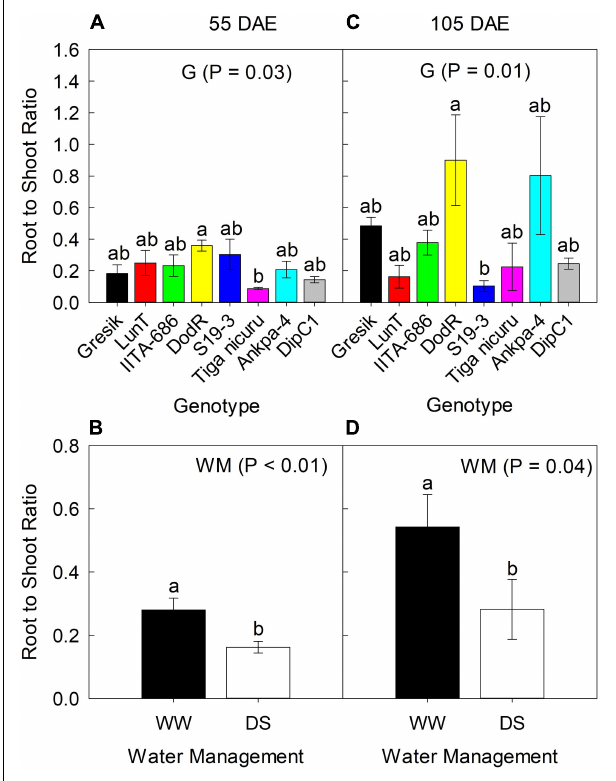
FIGURE 4 | Effect of Genotype (G) — (A,C) at 55 and 105 DAE (50 days of DS recovery), respectively, the data is mean ± SE values ( n = 6) and WM — (B,D) at 55 and 105 DAE (50 days of DS recovery), respectively, the data is mean ± SE values ( n = 24) on root to shoot ratio R:S of eight bambara groundnut genotypes during the 2019 season. Different letters showing significant differences by Tukey’s honest significant difference post hoc test for